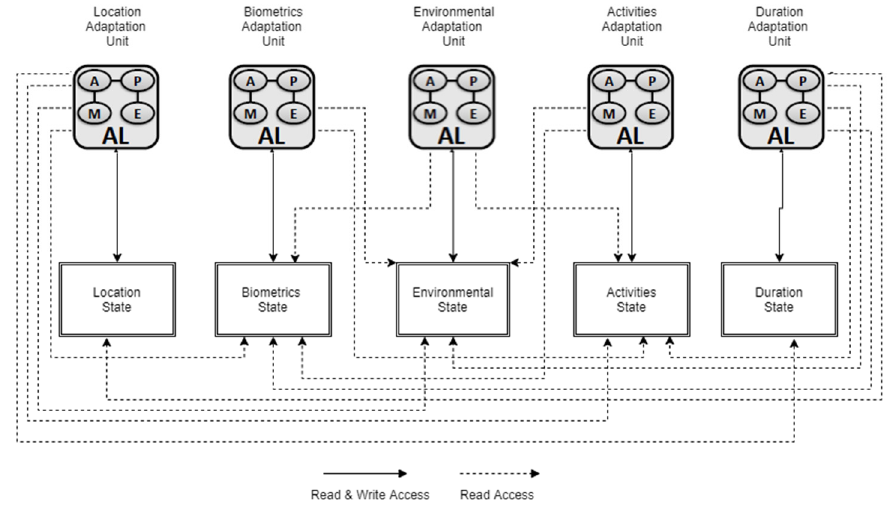
Figure 5. Subunits and substates.